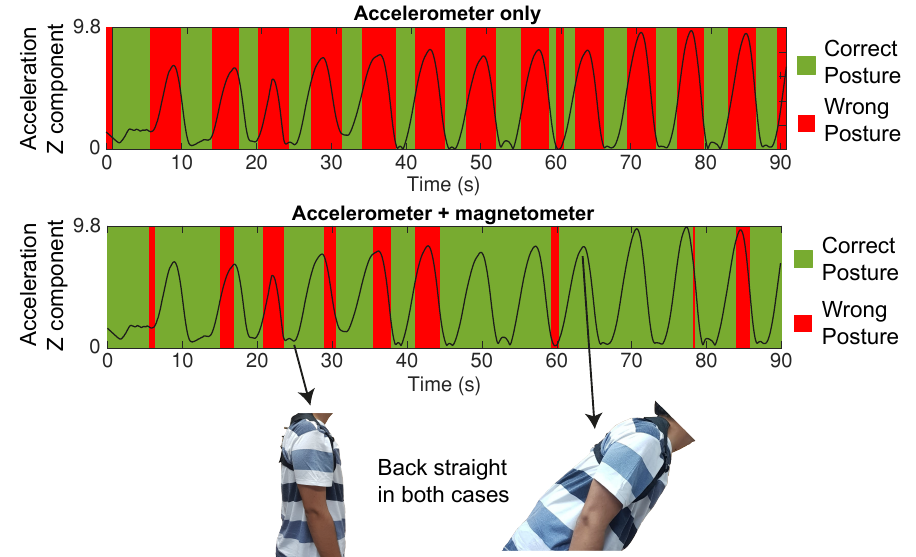
Figure 8. Posture quality classification result using accelerometer data only, accelerometer and magnetometer data simultaneously, and the posture assumed by the user during the test. The black line represents the measured acceleration in the Z component by the sensor. Despite the user tilting his back, it is kept straight during the entirety of the test.